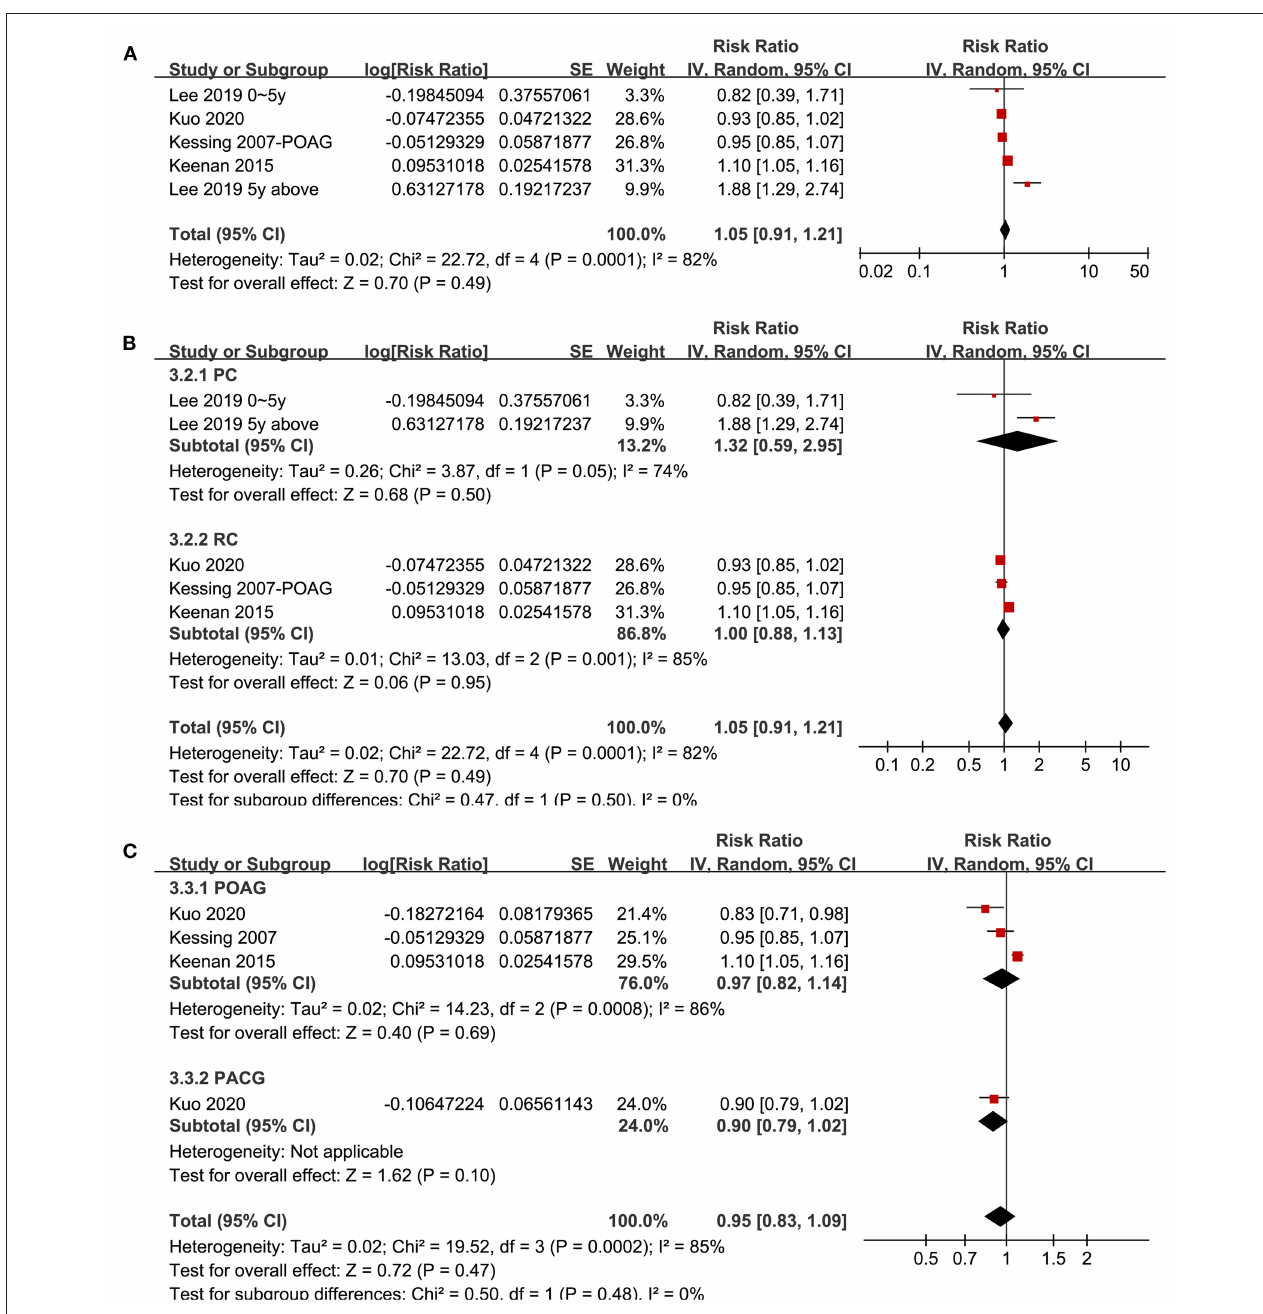
FIGURE 4 | Forest plots for the meta-analysis of the association between glaucoma and the incidence of non-AD dementia in adult population; (A) overall meta-analysis; (B) subgroup analysis according to the study design; and (C) subgroup analysis according to the type of glaucoma.